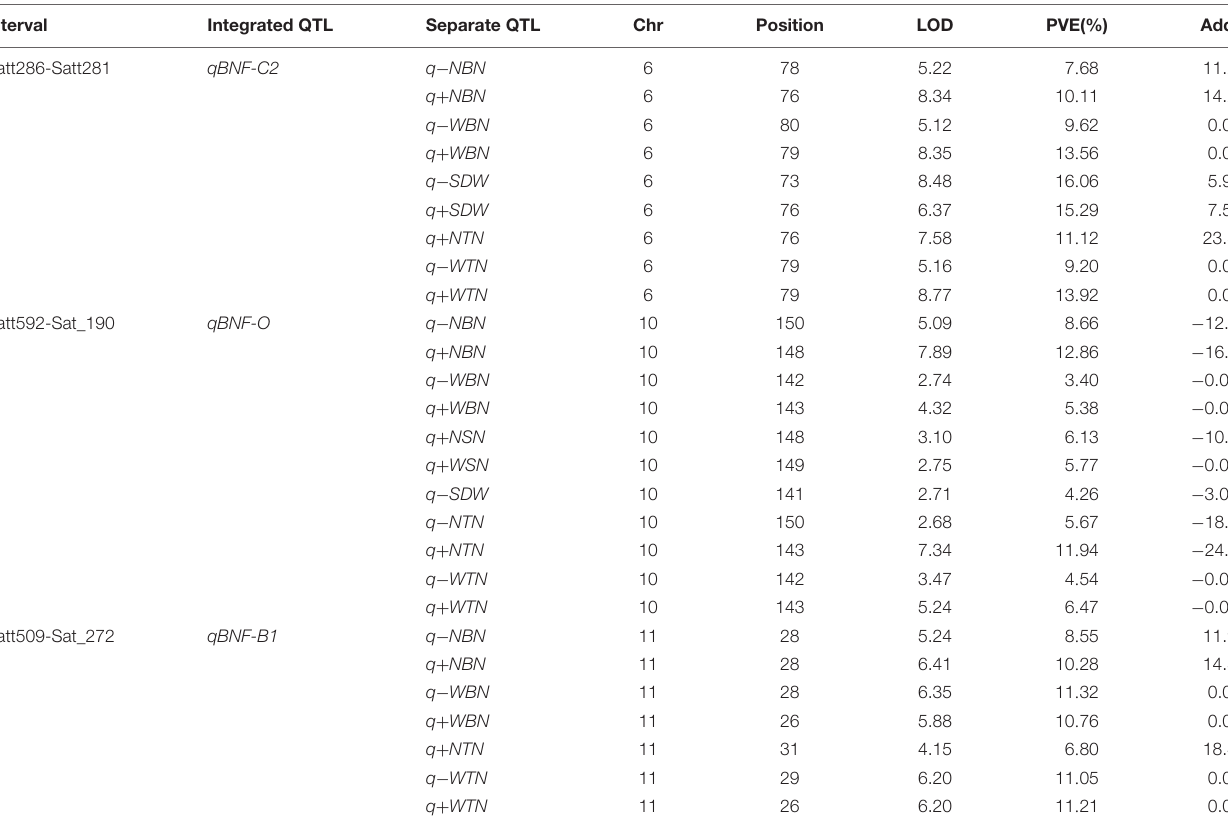
TABLE 3 | Putative QTLs detected for biological nitrogen fixation (BNF) traits and SDW using 175 F 9 : 11 soybean RILs in field. Interval Integrated QTL Separate QTL Chr Position LOD PVE(%) Add Satt286-Satt281 qBNF-C2 q −